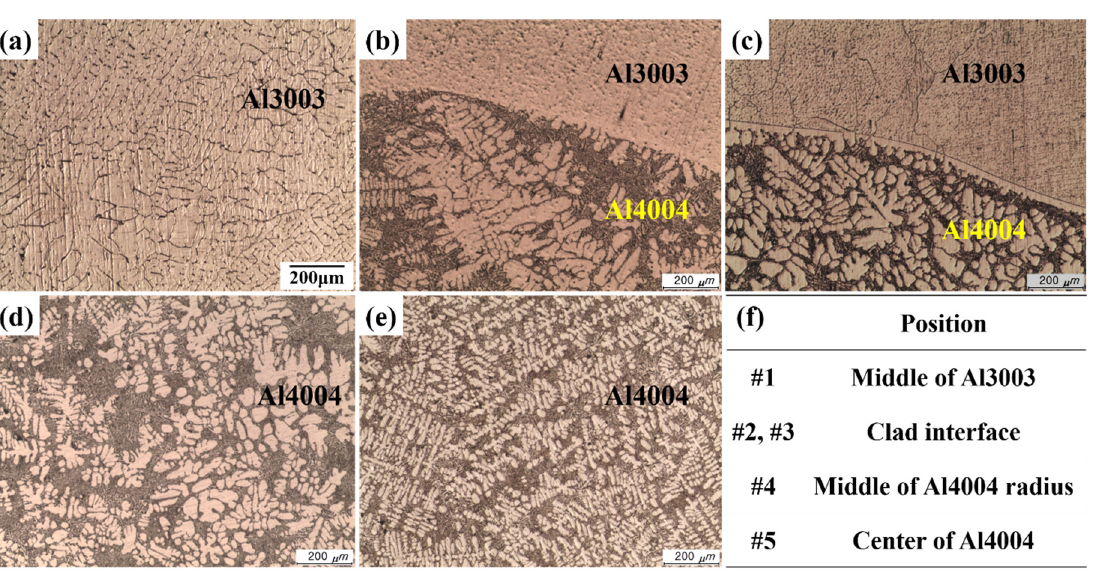
Figure 3. As-received microstructures of duo-casted Al3003/Al4004. Sampling positions ( a ) #1 in Al3003, ( b ) #2 in Al3003/Al4004, ( c ) #3 in Al3003/Al4004, ( d ) #4 in Al400, and ( e ) #5 in the Al4004 region, and ( f ) sampling positions (same magnification).